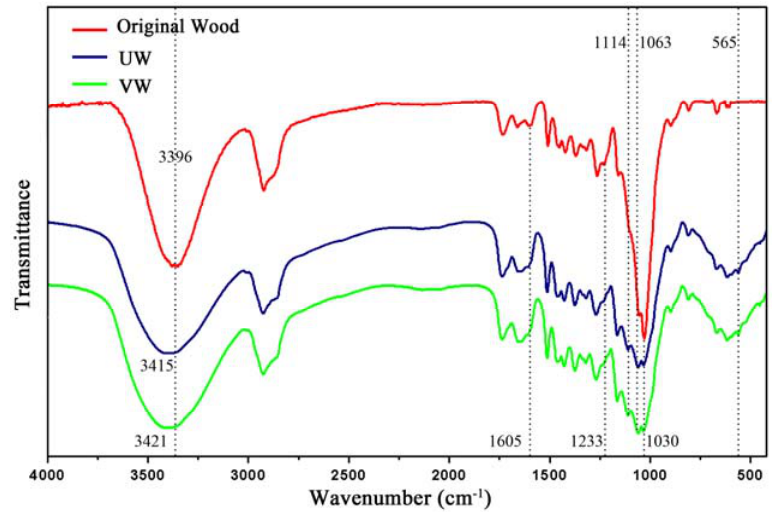
Figure 11. Fourier transform infrared spectroscopy (FTIR) of original wood, UW, and VW.